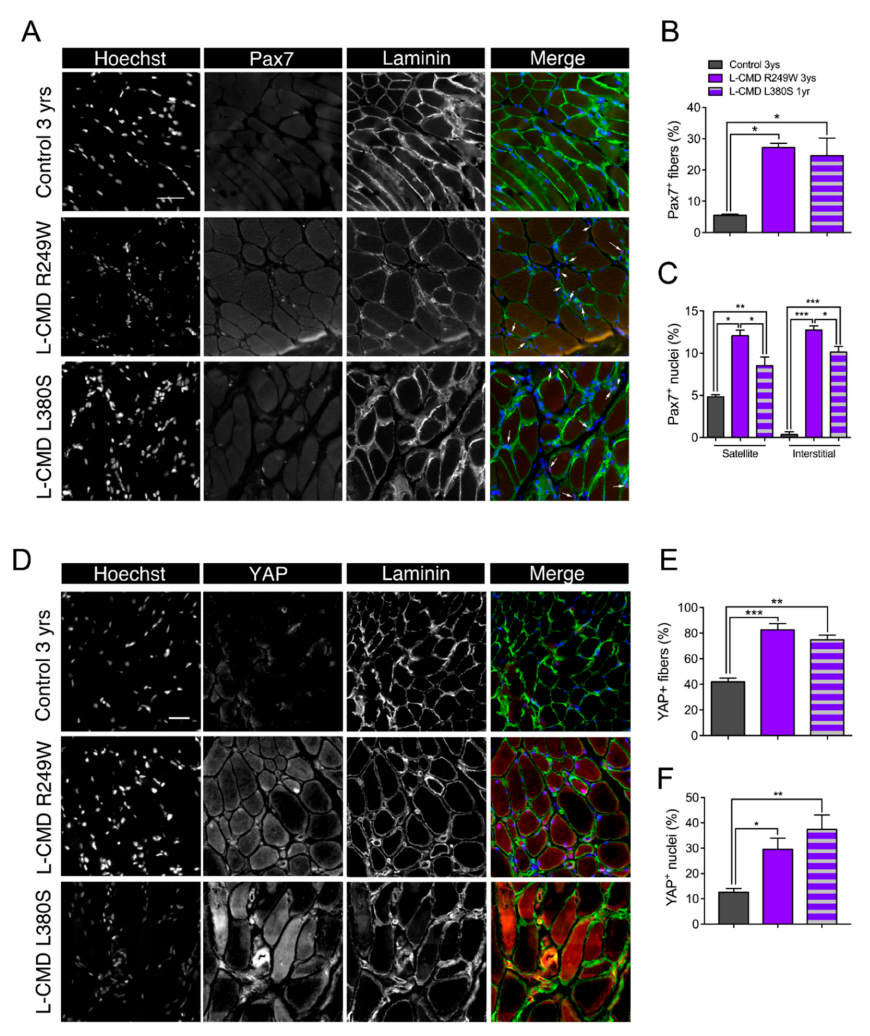
Figure 8. Histological data from muscle biopsies of patients with LMNA -CMD. ( A ) Immunofluores- cence images of Pax7+ (green) and laminin (red) in muscle section from a control 3-year-old boy, a 3-year-old boy with R249W mutation and a 1-year-old boy with L380S mutation. Nuclei are stained with Hoechst (blue). Scale bar: 50 µ m. ( B , C ) Quantification of Pax7+ cells per fiber and Pax7+ cells per nucleus in control and LMNA -CMD patients. Pax7+ cells in satellite or interstitial positions were determined. * p < 0.05, ** p < 0.01 and *** p < 0.001 versus control. ( D ) Immunofluorescence images of yes-associated protein (YAP, in green) and laminin (red) in muscle section from a control 3-year-old boy, a 3-year-old boy with R249W mutation and a 1-year-old boy with L380S mutation. Nuclei are stained with Hoechst (blue). Scale bar: 30 µ m. ( E , F ) Quantification YAP+ cells per fiber and YAP+ cells per nucleus in control and LMNA -CMD patients. * p < 0.05, ** p < 0.01 and *** p < 0.001 versus control. Values are expressed as means ±